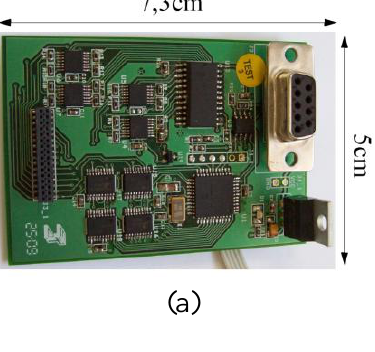
Figure 10. ( a ) Photograph of the electronics. ( b ) simplified